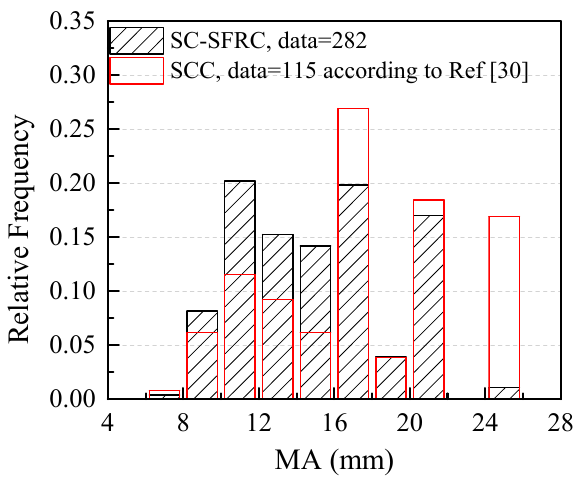
Figure 3. The probability distribution of maximum particle size of coarse aggregates.